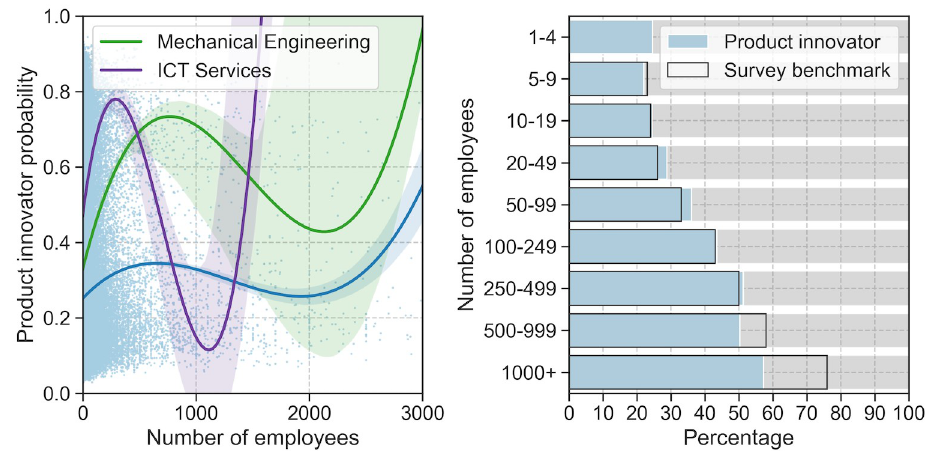
Fig 5. Predicted product innovator firms by size. Left panel: Product innovator probabilities by firms size (number of employees) with fitted third order polynomial regression line with 95% confidence interval; all sectors (blue), ICT services (purple), mechanical engineering (green). Right panel: Share of product innovator firms by size classes (predictions in blue; survey extrapolations transparent).